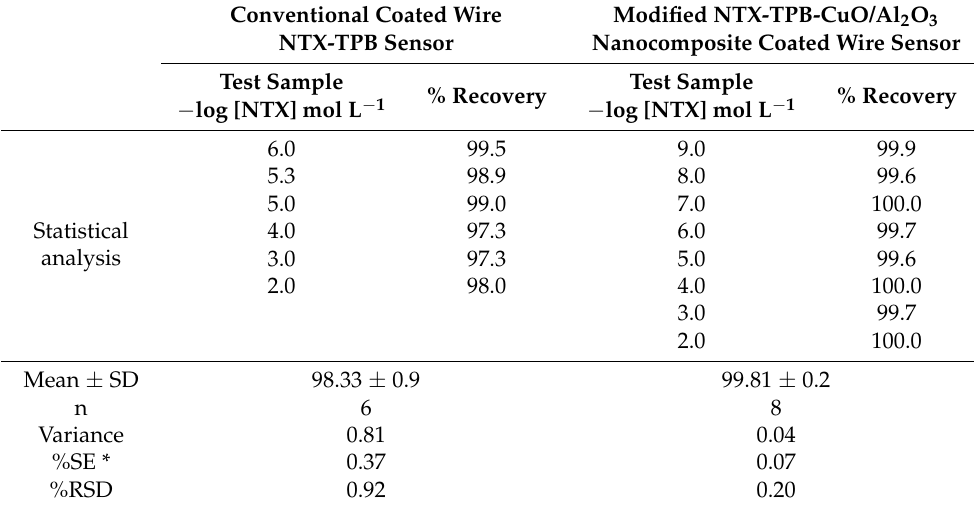
Table 3. The calculated resulted of pure NTX estimation using the designed conventional